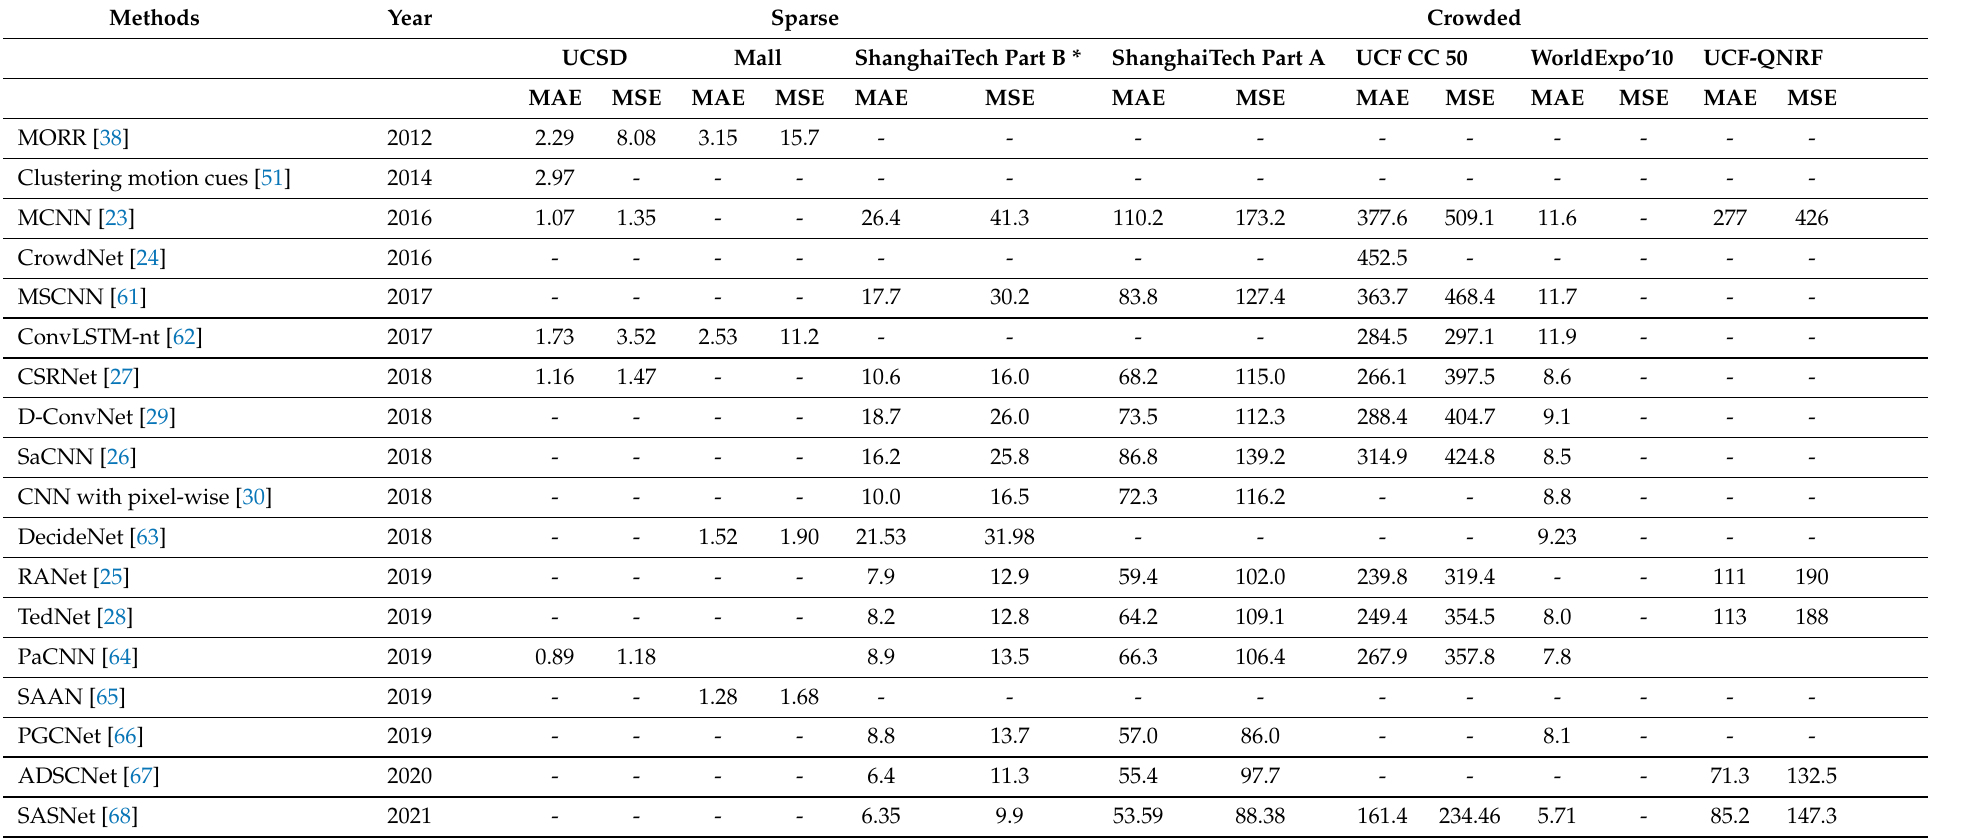
Table 4. Comparison of the performance of different methods on the used crowd counting